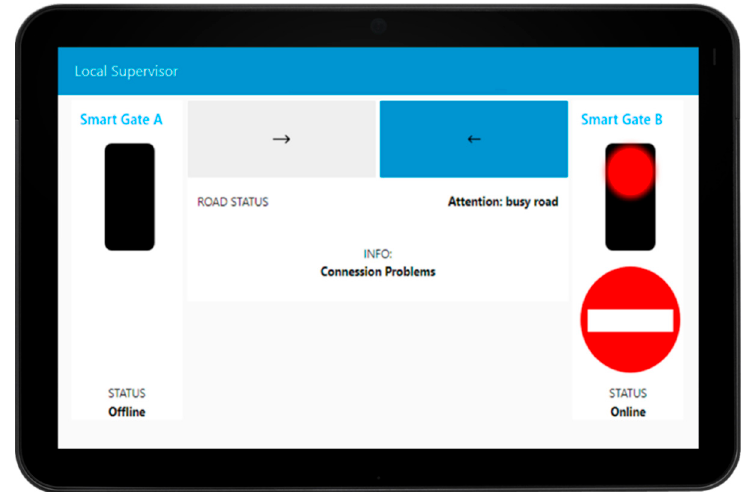
Figure 12. The local supervisor interface in case of inconsistency and following a connection problem with the smart gate A.